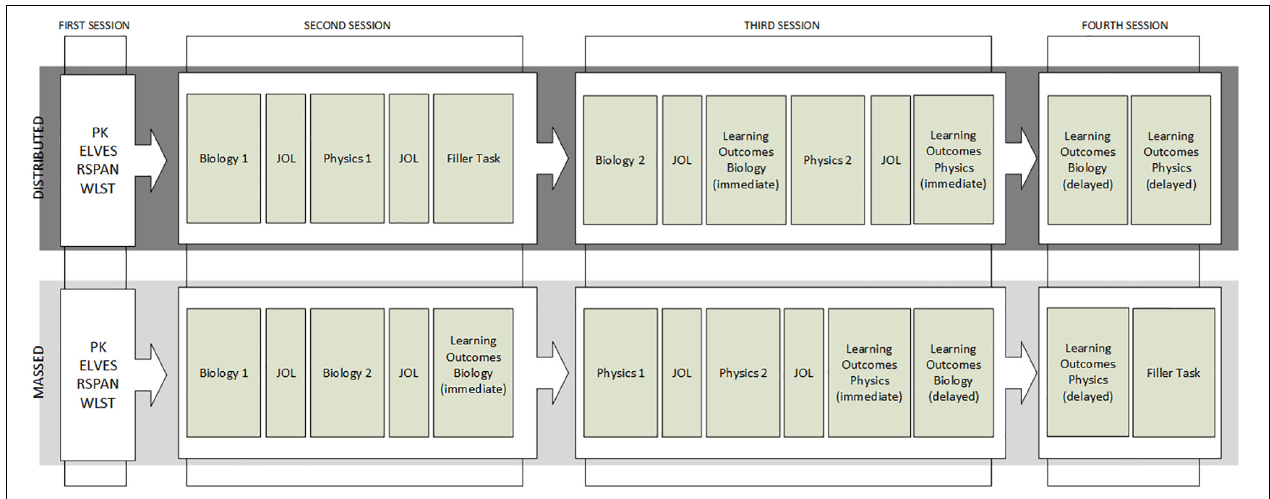
FIGURE 1 | Procedure of Experiment 1. An illustration of the procedure of Experiment 1. Order of topics was counterbalanced between students (only one example is shown here). PK = Assessment of prior knowledge; ELVES = Assessment of reading ability; RSPAN = Assessment of working memory; WLST = Assessment of reading strategy knowledge; Biology 1 = first text biology; JOL = assessment of meta-cognitive judgments of the learning process; Physics 1 = first text Physics; Biology 2 = second text biology; Physics 2 = second text physics; Learning outcome physics = assessment of learning outcome for physics; and Learning outcome biology = assessment of learning outcome for biology. Learning outcomes were measured immediate after learning (immediate) and 1 week delayed